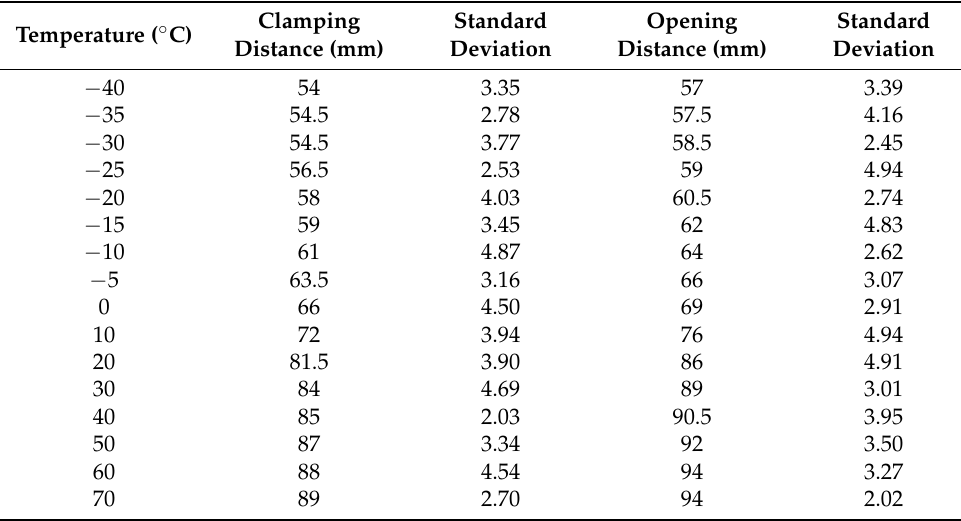
Table 3. SA 220 magnetic contact on and off values during experimental